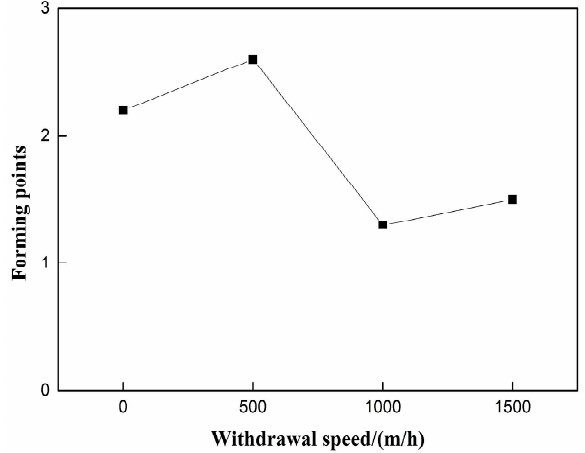
ff ect of withdrawal speed on weld forming. Figure 9. Effect of withdrawal speed on weld forming. Figure 9. E